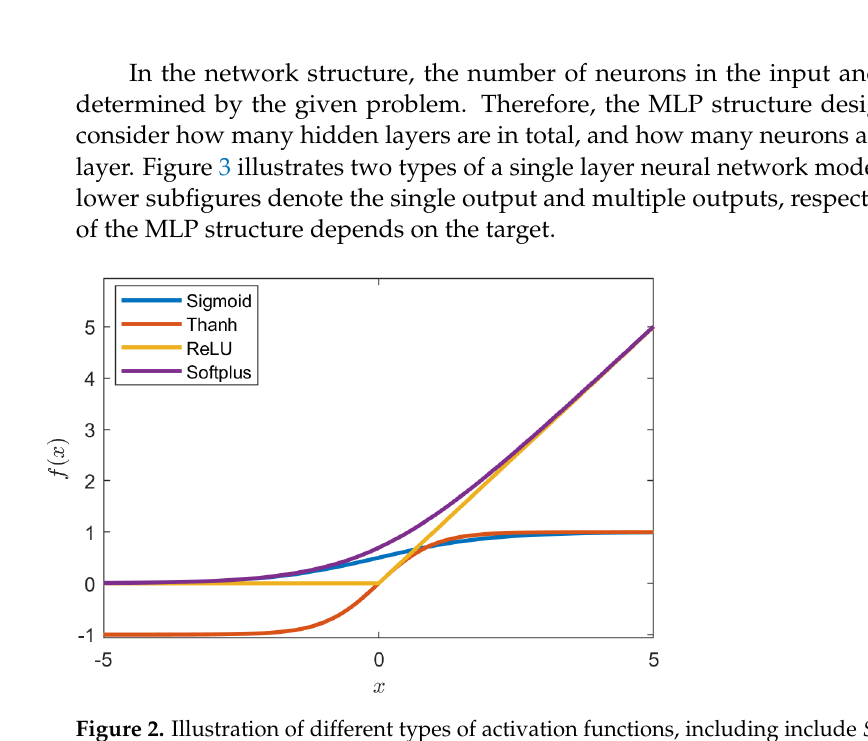
Figure 2. Illustration of different types of activation functions, including include Sigmoid , Tanh , Relu and softplus .